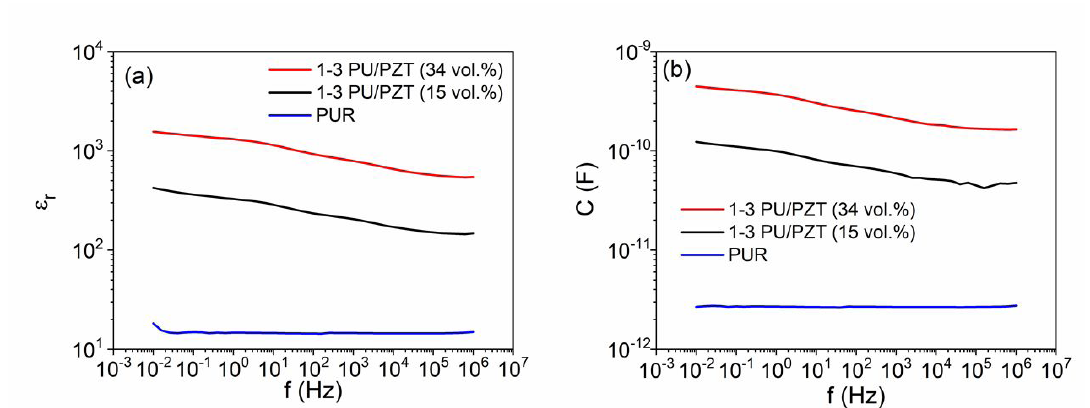
Figure 6. Evaluation of the (a) relative permittivity and (b) capacitance as a function of frequency at room temperature for the samples of the 1-3 piezoelectric composite and for the neat